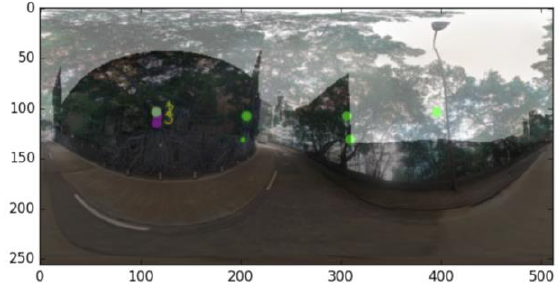
Figure 14. Result for a processed equirectangular image with detected points. This image is generated by fusing RGB with Depth images. The detected points (green and purple dots) are marked inside the image.